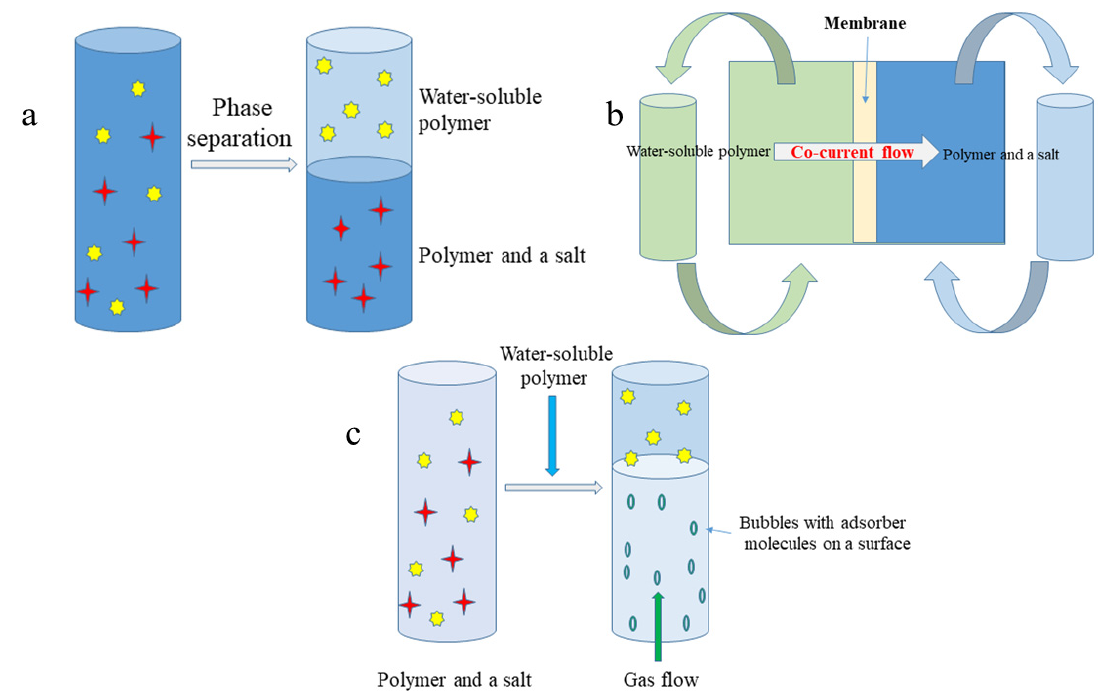
Figure 1. Schematic representation of: ( a ) aqueous two phase system (ATPS) one step liquid-liquid extraction; ( b ) membrane supported liquid-liquid extraction (Memex); ( c ) aqueous two phase flotation (ATPF) system.